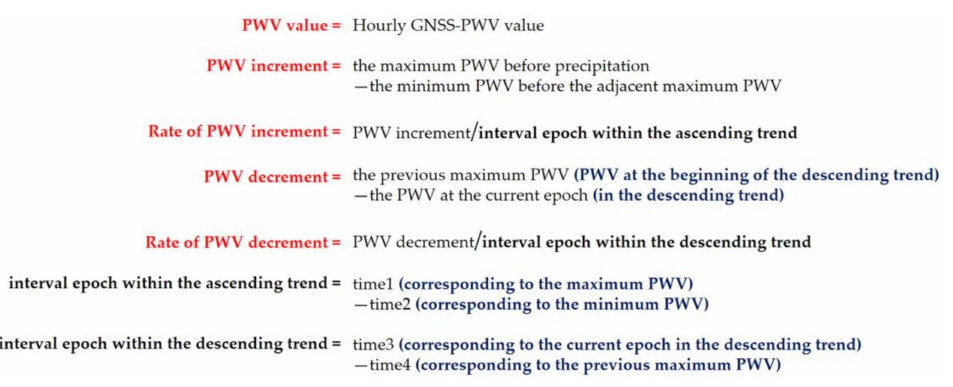
Figure 5. Definitions of the five predictors used in this